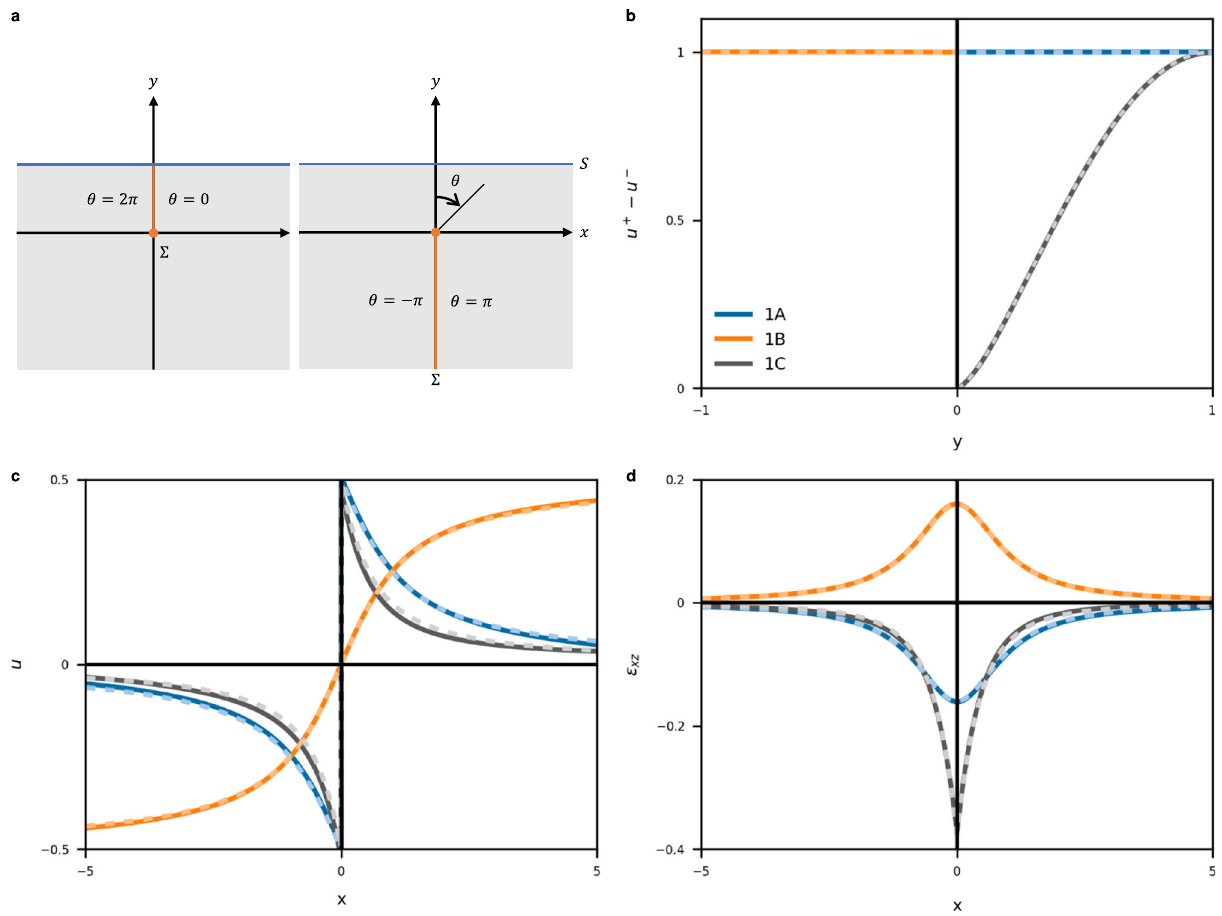
Fig. 2 | Model and estimated results in a homogeneous half-space. a Model structures. The orange and blue lines represent fault Σ and Earth ’ s surface S , respectively.Surface(left)andburied(right)faultsaredistinguishedbythebranch cut. b Assumed displacement discontinuities on the fault. c Estimated surface